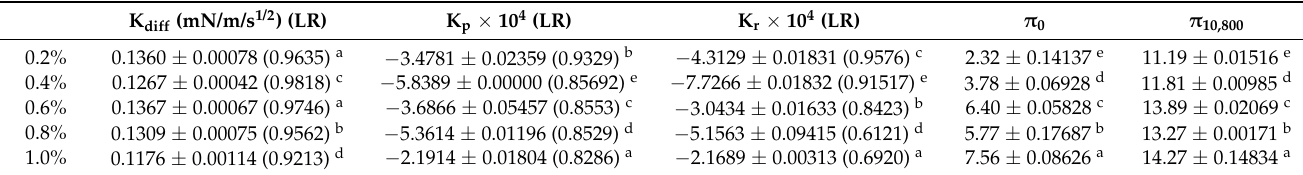
LSEP at different